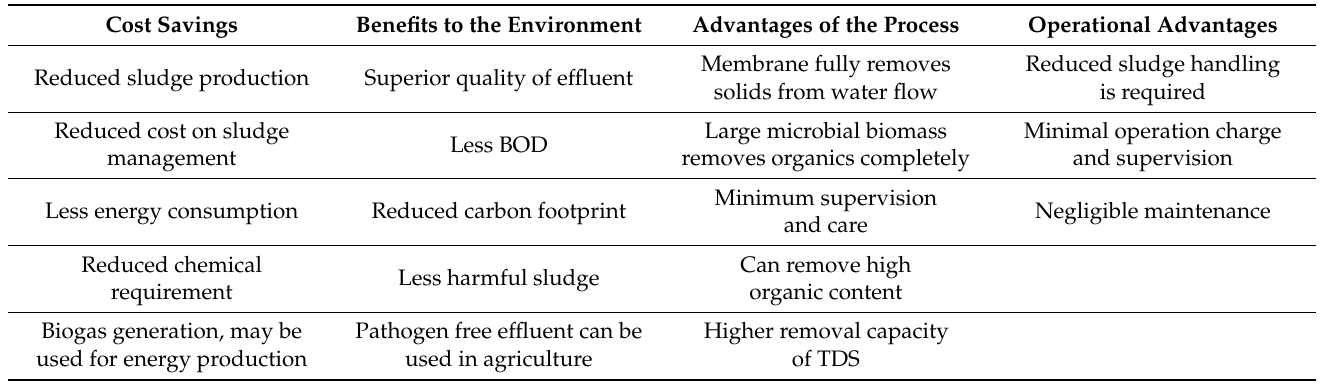
Table 2. Advantages of the AnMBR technique.